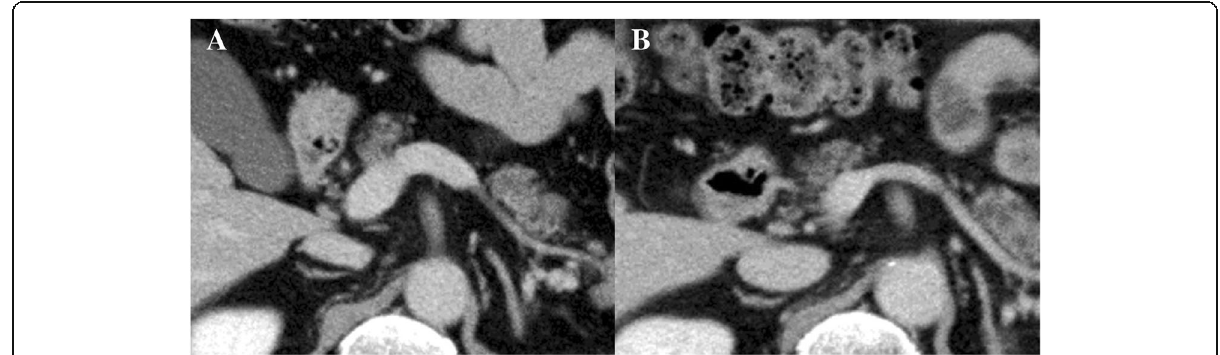
Table 1 Cases of left-sided colorectal cancer comorbid abnormal vessel communications of pelvis Case Sex Age Location of